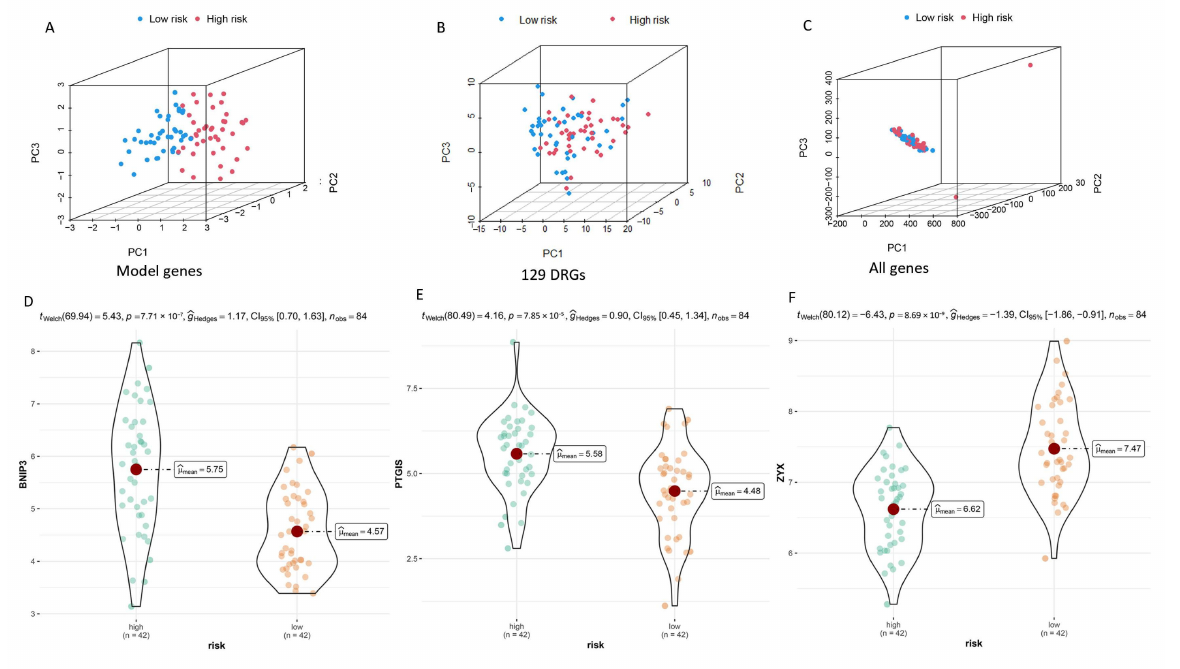
Figure 6. PCA plots depicting the distribution of samples based on the expression of model genes ( A ), DRGs ( B ), and all genes ( C ). Differential expression of model genes in the high- and low-risk groups is shown in box plots ( D – F